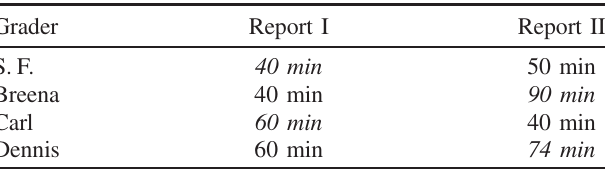
TABLE X. The table shows the grader, the report, the grading method and the total grading times. The method is indicated by font: roman font for rubrics and italic font for comments.